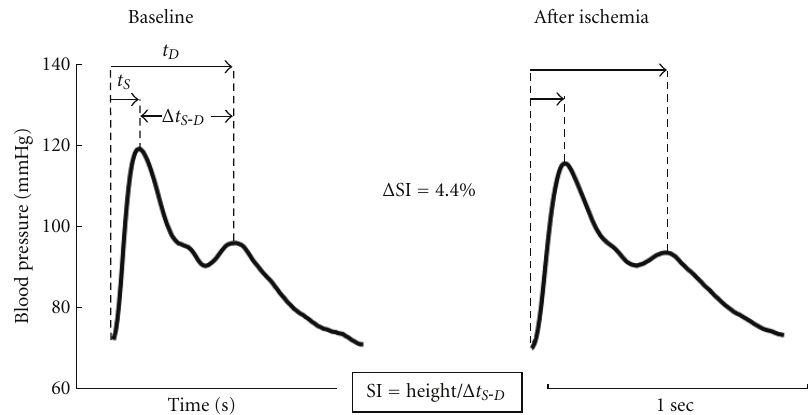
Figure 5: An example of the e ff ect of forearm ischemia and RH on the radial pressure waveform in a single individual. The changes in the wave shape are quantified using the sti ff ness index (SI), calculated as the relationship between the subject height and the time delay in the systolic and diastolic peaks ( Δ t S - D ). It can be seen that Δ t S - D is increased (reducing SI value) by the 5 minutes of occlusion and cu ff deflation. t t S and D are time from foot to peaks systolic and diastolic, respectively.